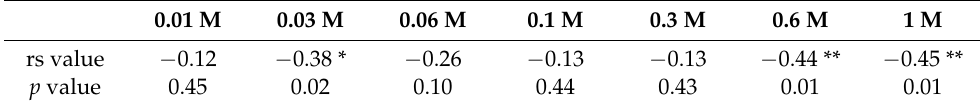
Figure 5. Total hedonic ( a ) and aversive ( b ) responses at the 1 M sucrose concentration in the taste reactivity test. The total number of hedonic responses was calculated as the sum of tongue protru- sion, paw licking and mouthing responses. The total number of aversive was calculated as the sum of head shaking, forelimb flailing, snout cleaning and gagging responses. Data are expressed as the Table 2. Correlation between leptin levels and sucrose preference ( n = mean ± SEM. * p < 0.05 STD vs. CAF-RO group; # p < 0.05 CAF-R vs. CAF-RO group.